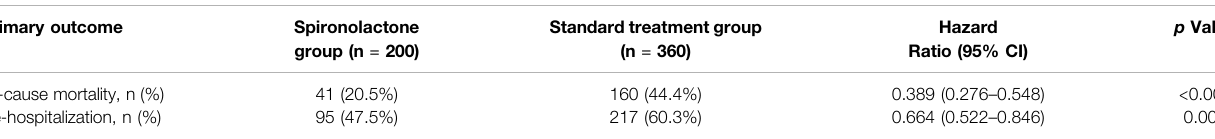
TABLE 2 | Primary outcome after